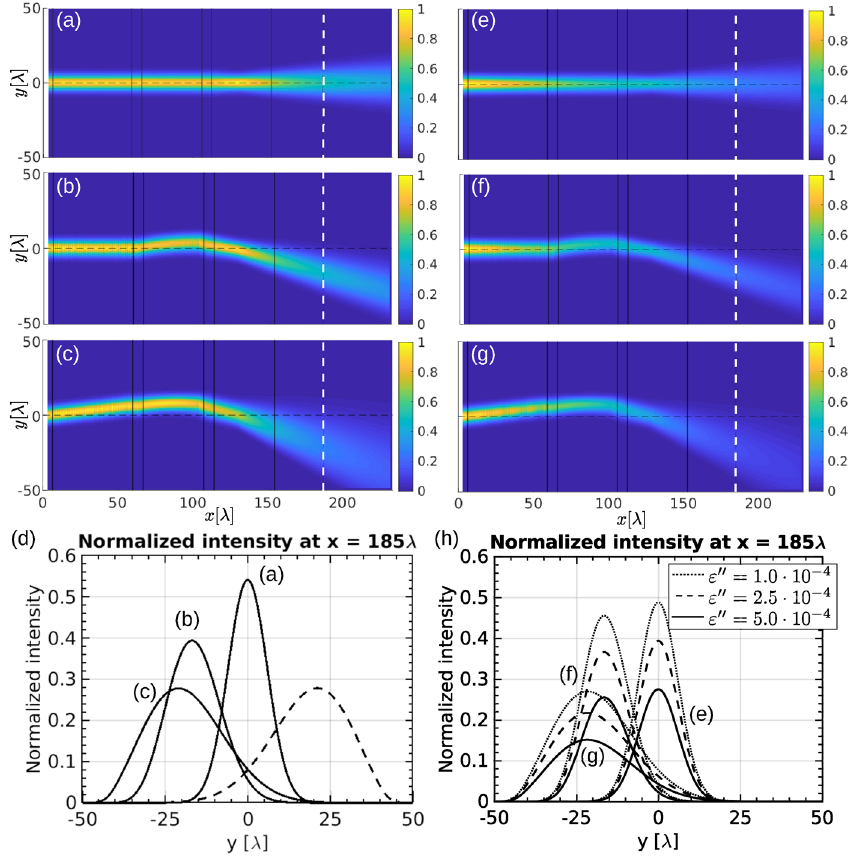
Figure 7. Tuning of beam control device. ( a ) LC beam controller in an “off” state. The LC director field is homogeneous in first (shift) and second (deflector) building blocks, so there is no shift or deflection. The total deflection angle is thus γ = 0 ◦ and the beam is only expanded. ( b ) Medium beam deflection of γ ∼ 15 ◦ . The deflector deformation width is set to w d = 66.6 (cid:31) to achieve the desired deflection angle for a selected beam waist (see Fig. 4) and the shifter building block angle is kept at θ = 0 ◦ because the beam will already get shifted enough by deflector. ( c ) Large beam deflection. The deflector deformation width is narrowed to w d = 40 (cid:31) to achieve larger deflection angle and the shifter building block is adjusted to the angle θ ∼ 23 ◦ to compensate for a larger decentering of the beam due to larger deflection angle. The beam is expanded fully downwards to an angle of γ ∼ 20 ◦ . ( d ) Intensity profiles of all three beams at the position marked with the vertical dashed line in panels ( a – c ). Dashed line represents the profile of the beam after large deflection in the opposite direction. Expander building block (lens) remains unchanged for all cases. ( e – g ) Propagation of the beam through the lossy material with the same parameters as in ( a – c ), respectively. Complex part of permittivity was set to ε ′′ = 5 × 10 − Intensity profiles of all three beams at the position marked with the vertical dashed line in panels ( e – g ) for different values of ε ′′